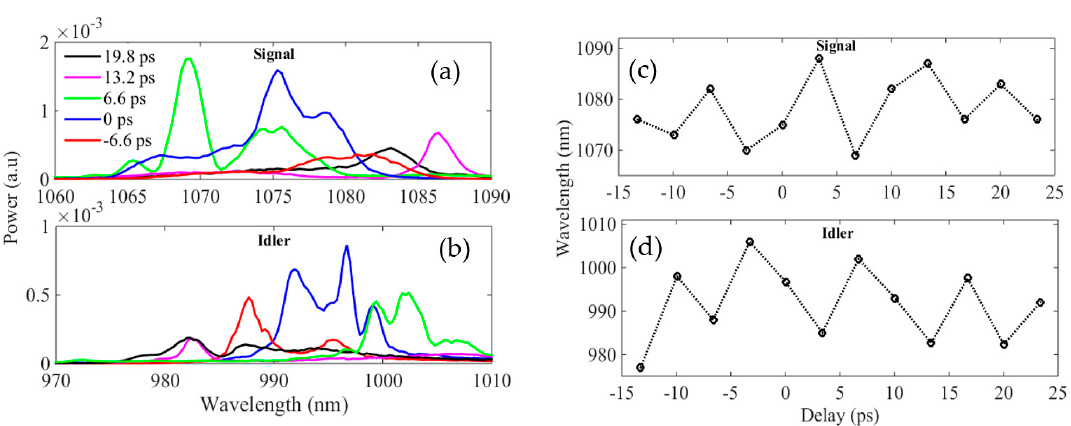
Figure 6. ( a , b ) Selection of amplified and idler spectra when the delay is tuned from − 6.6 ps to +19.8 ps. ( c , d ) Variation of the signal and idler wavelengths at the maximum amplification as a function of the delay.